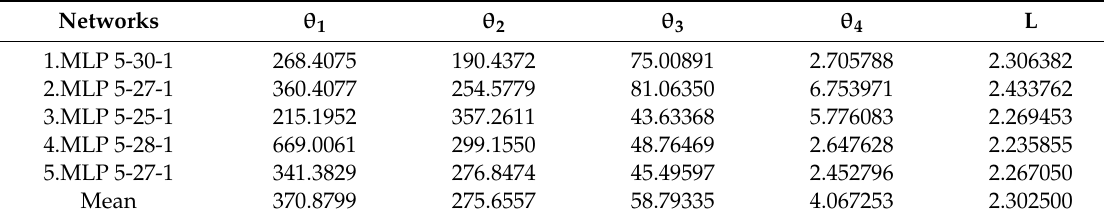
Table 4. Results from the global sensitivity analysis of the obtained neural networks.